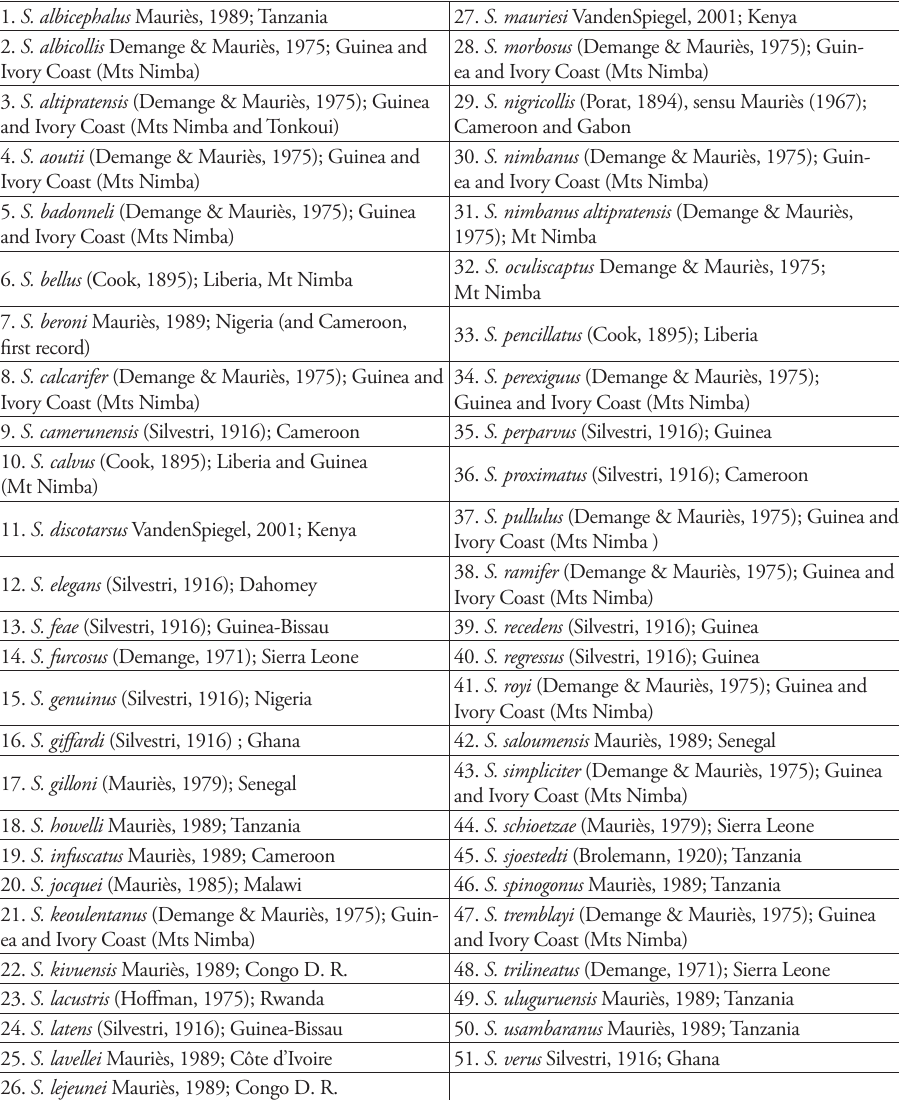
Table 1. Checklist of the African species of Stemmiulus with locality or country